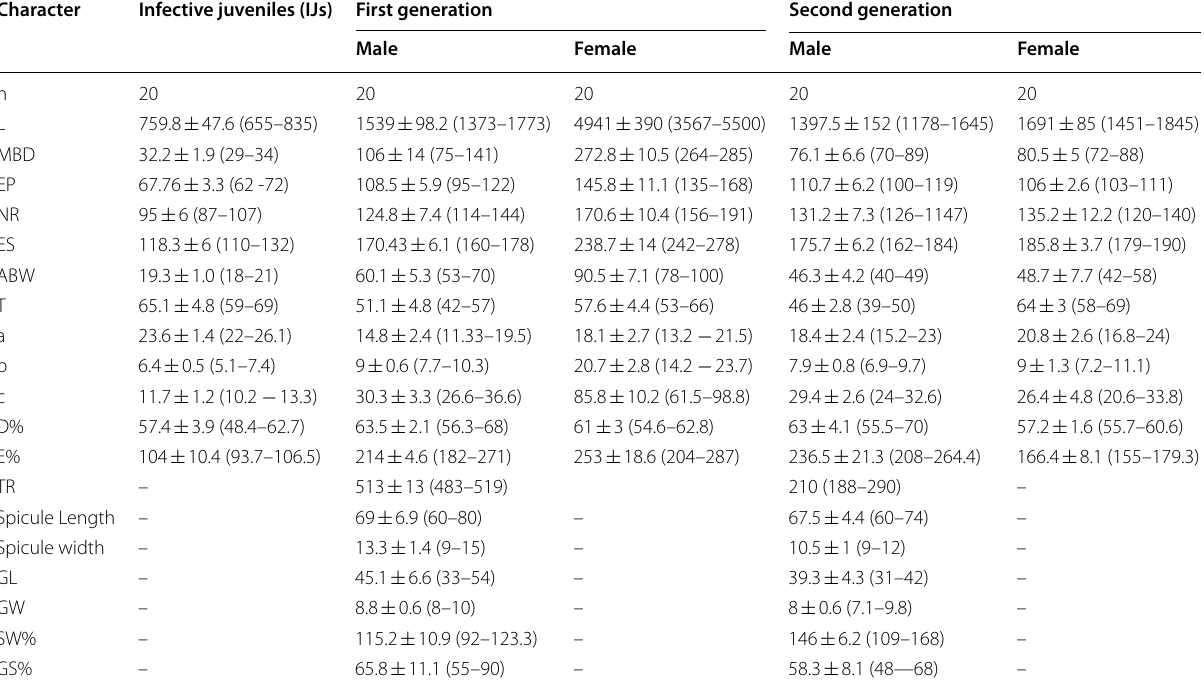
Table 2 Morphometrics of Steinernema affine